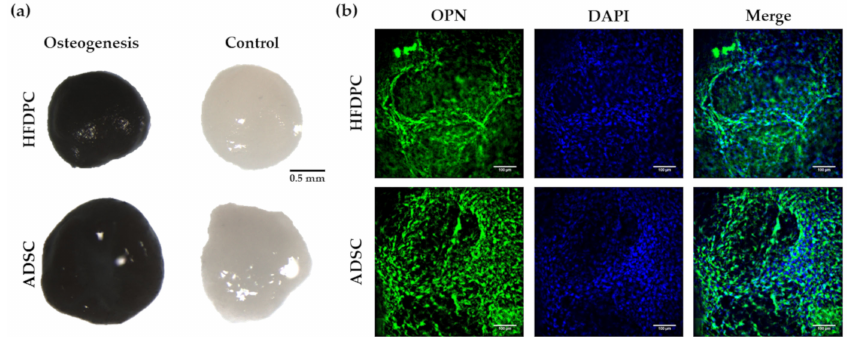
Figure 8. Characterization of osteogenic phenotype of HFDPC and ADSC cultured in RAD16-I sca ff old for 21 days. ( a ) von Kossa staining (calcium mineralization) of 3D constructs cultured in control and osteogenic medium; ( b ) OPN immunofluorescence of 3D constructs under osteogenic